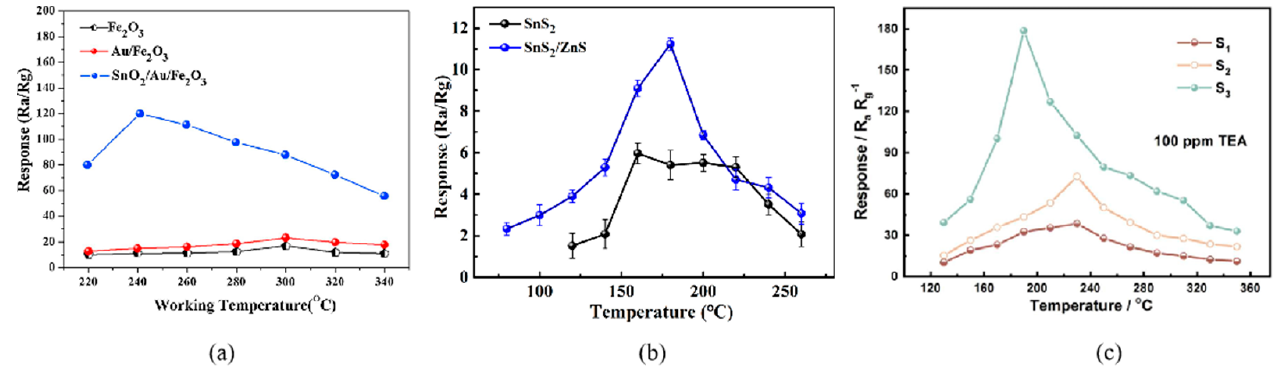
Figure 1. ( a ) The response curves of SnS 2 and SnS 2 /ZnS to 50 ppm TEA under various working temperatures [23]; ( b ) The response curves of Fe 2 O 3 , Au/Fe 2 O 3 , and SnO 2 /Au/Fe 2 O 3 to 100 ppm TEA at different operating temperatures [30]; ( c ) The response curves of sample-1, -2, -3 to 100 ppm TEA at various operating temperatures [31].